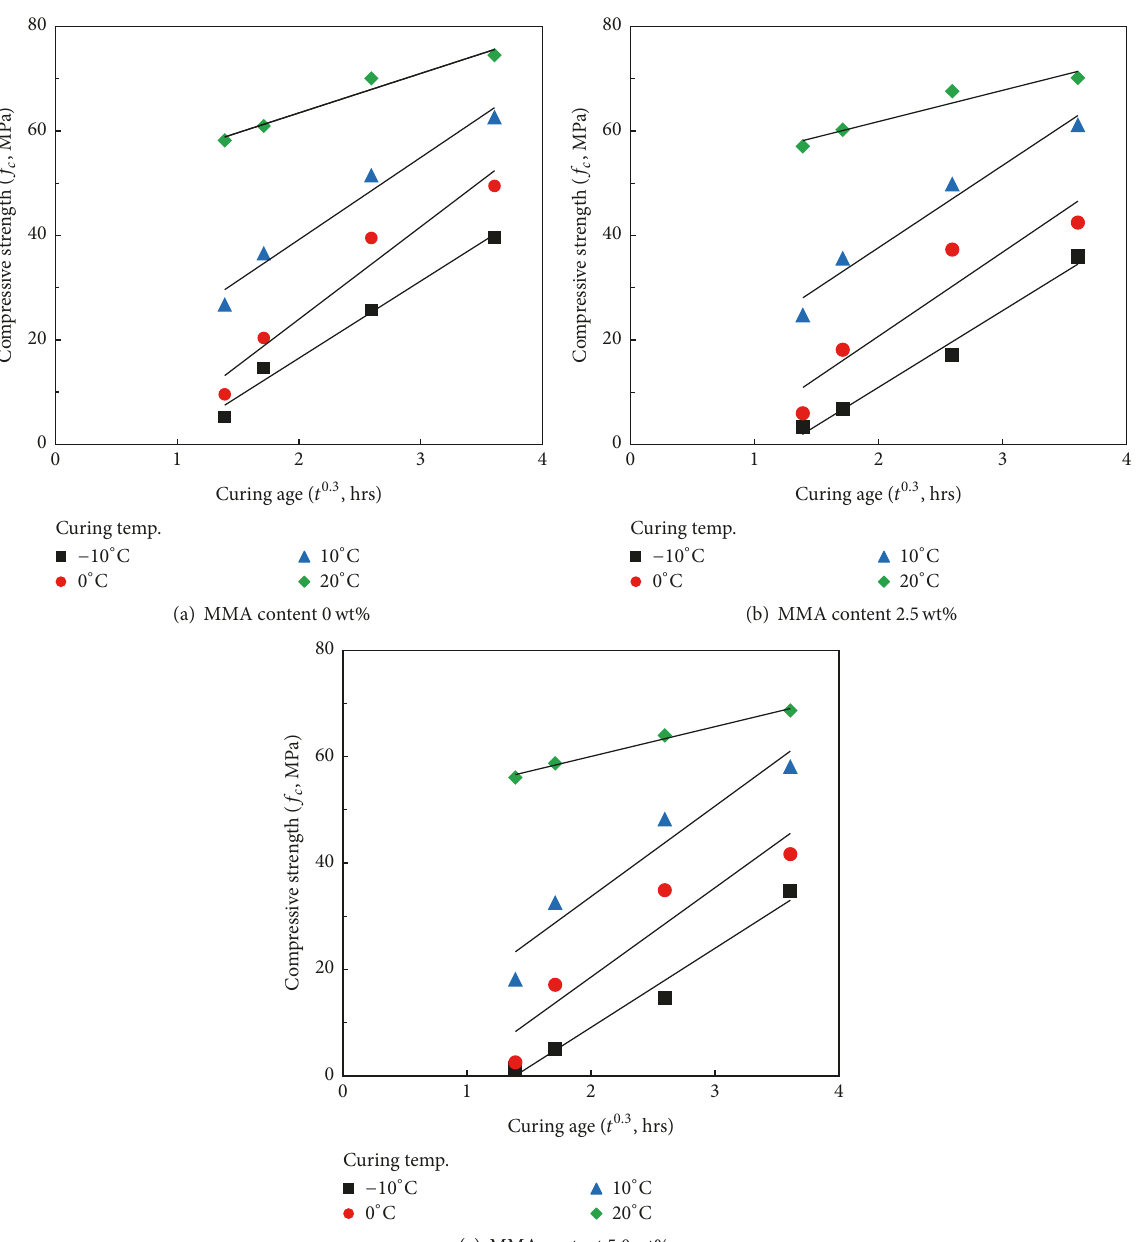
Figure 3: Curing age versus compressive strength for computation of the slope coefficient of strength.